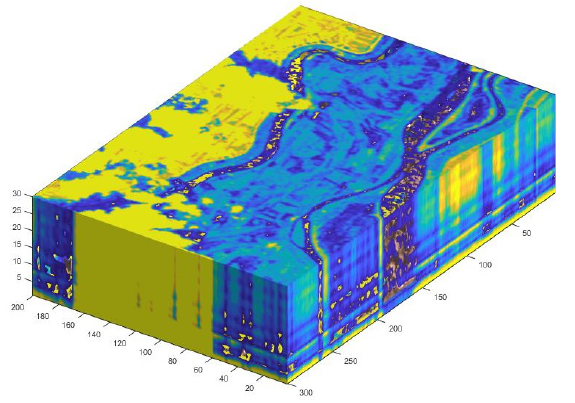
Figure 6. Three-dimensional representation of the data set.